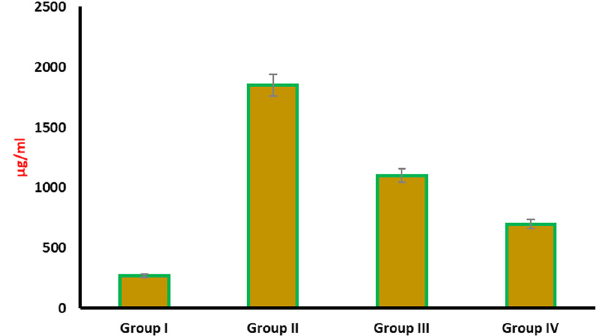
Figure 5: Levels of BALF total protein on AuNPs treatment in